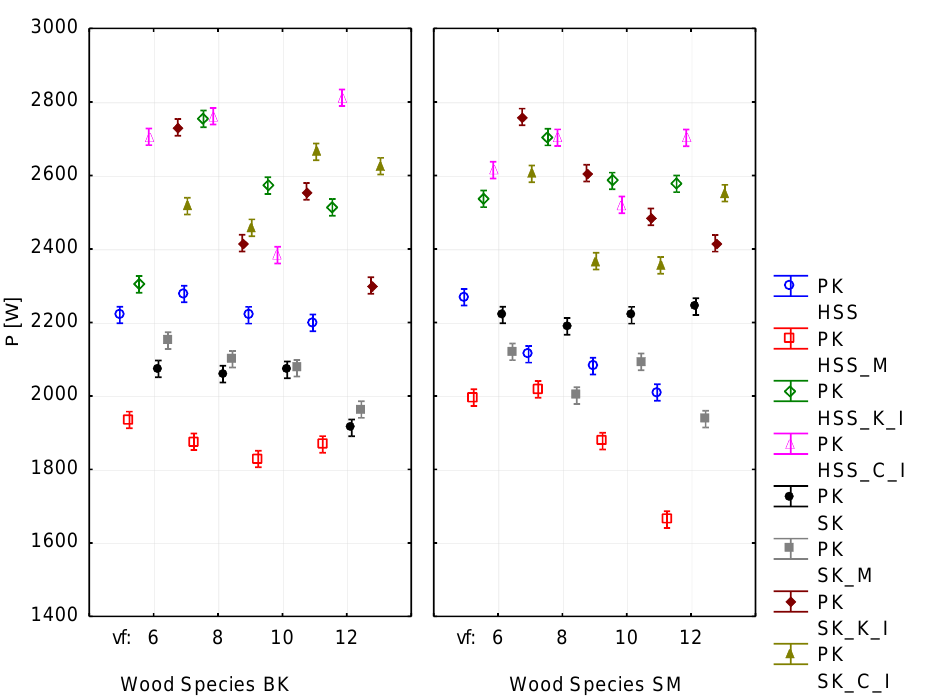
Figure 7. Average power values depending on the coating used and the feed speed. Figure 8 clarifies the interactions between the saw blades of the two groups and the cutting speeds. In the group of saw blades without SK blades, the saw blade with MAXIMIZER (AlTiN) coating has the significantly lowest energy consumption at every cutting speed. Although the saw blade with SK blades without coating differs very little, the saw blade with SK blades with MAXIMIZER (AlTiN) coating has the lowest statistical significance in the group of saw blades with SK blades.